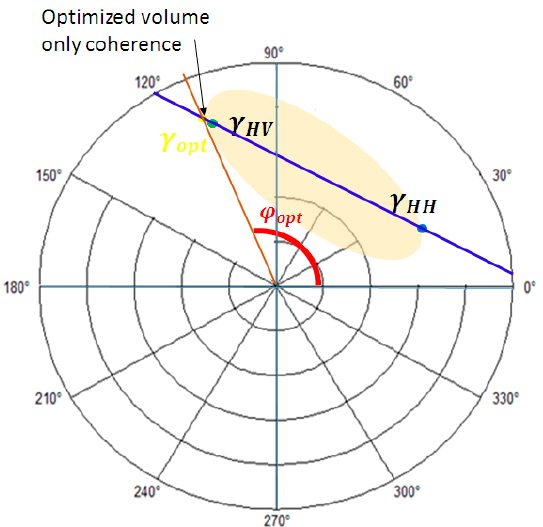
Figure 7. The volume coherence optimization using ESPO method for a dual polarization pixel.